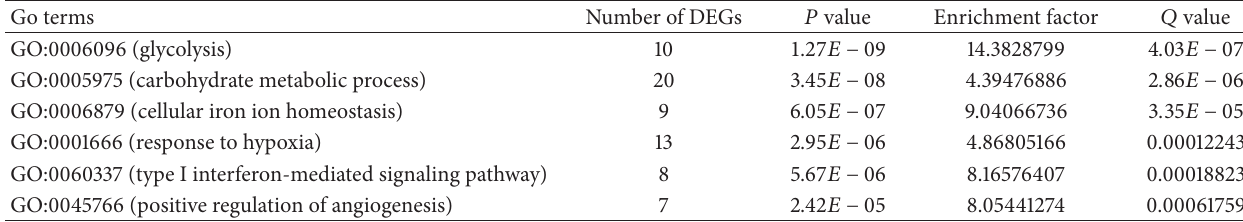
Table 1: The predominant enriched pathways with DEGs by Gene Ontology analysis.